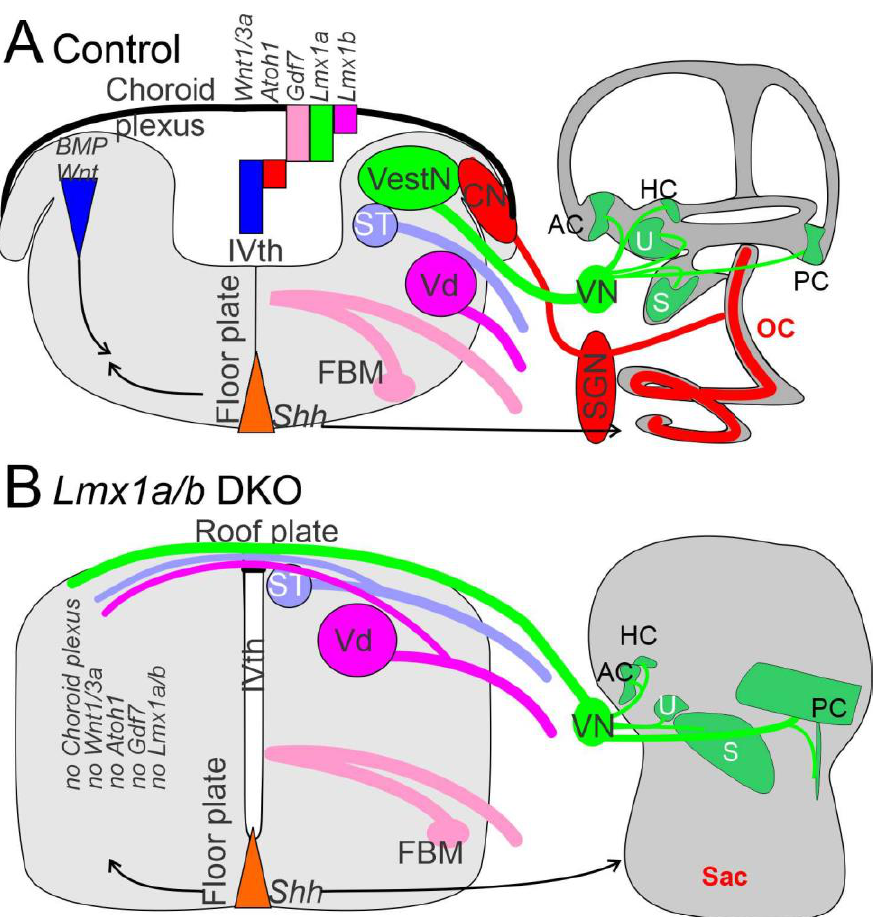
Figure 6. Central projections of the ear depend on the brainstem. Vestibular neurons project dorsally in the hindbrain in control and Lmx1a/b DKO mice (VIII; A , B ). In Lmx1a/b DKO mice, central cochlear projections never develop as they do in controls ( A , B ). In addition, in Lmx1a/b DKO mice, vestibular projections interconnect across the roof plate, whereas vestibular fibers are normally separated by the choroid plexus ( A , B ). In addition to the loss of the cochlea and spiral ganglion neurons, the cochlear nucleus does not form in Lmx1a/b DKO mice ( B ). Furthermore, in Lmx1a/b DKO mice, Atoh1, Gdf7 and Wnt1/3a expressions are absent ( A , B ). The signal of Shh drives both the ventral brainstem and ventral cochlea (arrows), which are altered without dorsal interaction and lack cochlear neurons in Lmx1a/b DKO mice ( A , B ). AC, HC, PC, anterior, horizontal, posterior cristae; CN, cochlear nuclei; FBM, facial branchial motoneurons; S, saccule; SGN, spiral ganglion neurons; ST, solitary tact; U, utricle; Vd, trigeminal; VestN, vestibular nuclei; VN, vestibular neurons. Modified after [11,28,153].